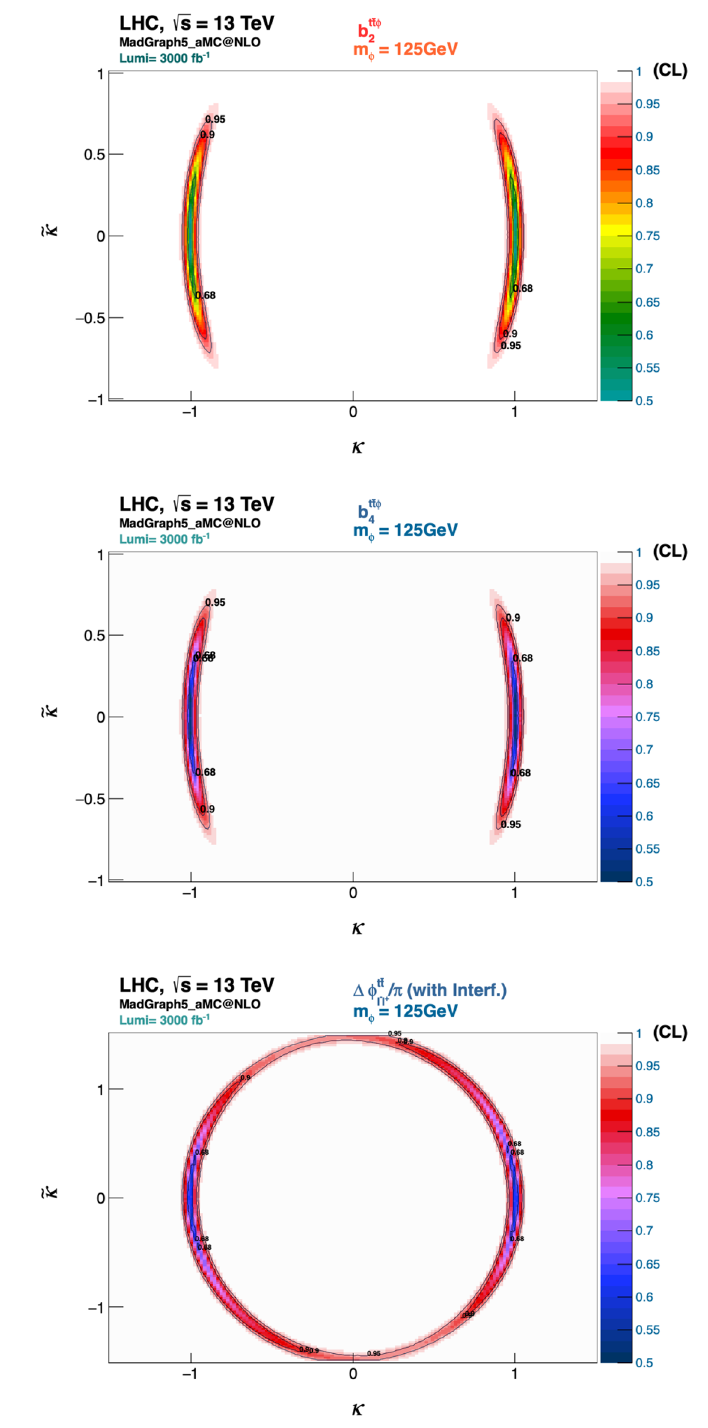
Figure 9 . Expected exclusion limits for the t ¯ tφ CP-couplings for a fixed luminosity of 3000 fb − 1 and for the b t ¯ tφ (top) and b t ¯ tφ (middle) variables are shown, at the HL-LHC. The effect of interference 2 4 effects is also shown (bottom) for the ∆ φ t ¯ t angular ll